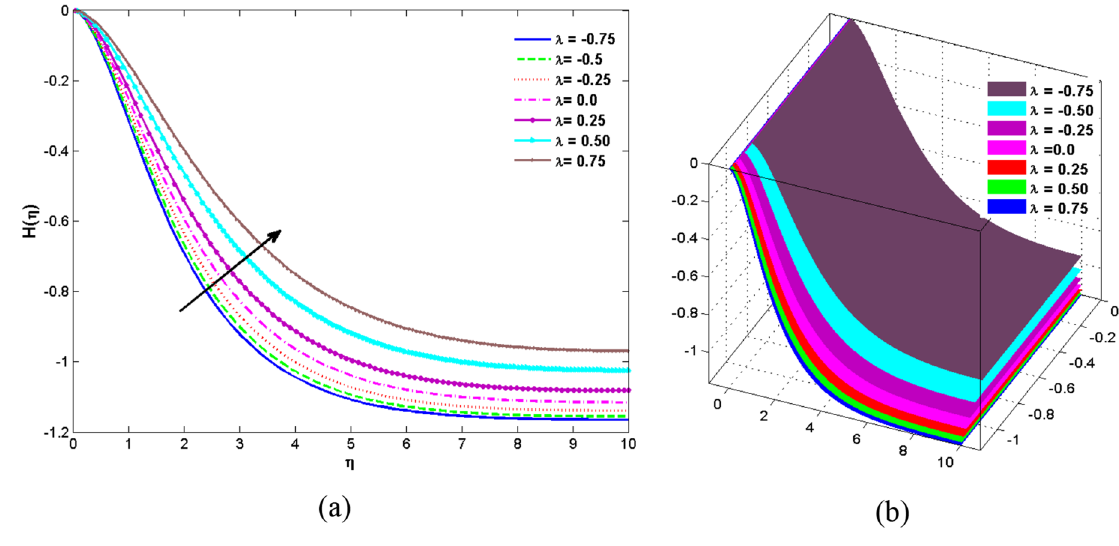
Figure 5. Variations of (cid:31) to H (η) .